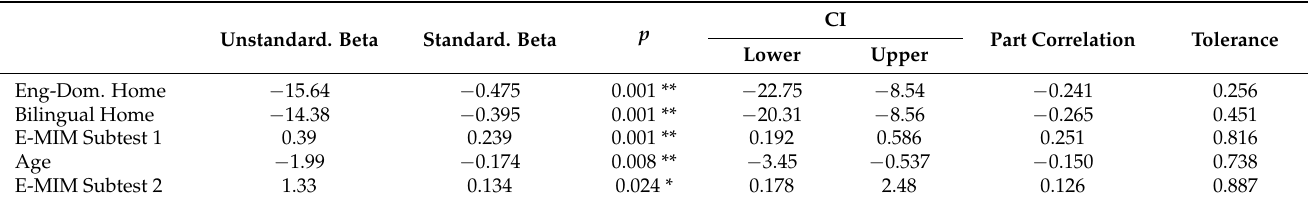
Table 3. Outcome of regression on E-MIM Subtest 3.